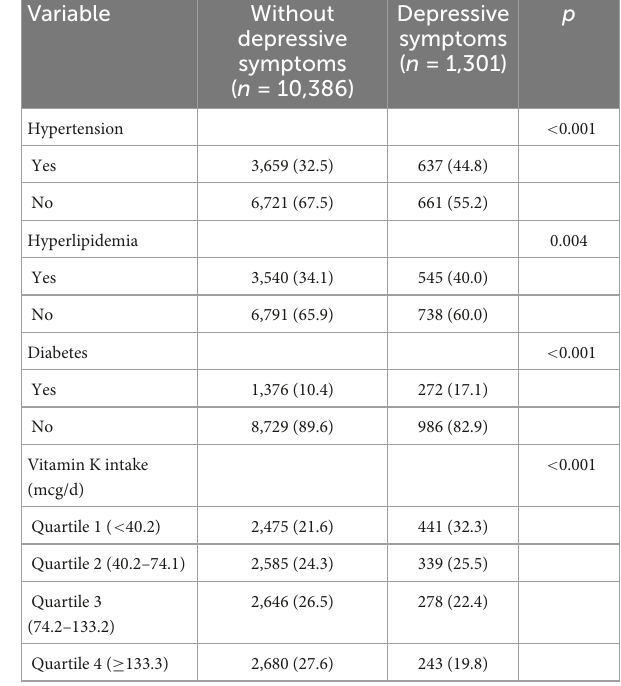
TABLE 1 Characteristics of the participants by depressive symptoms ( n =